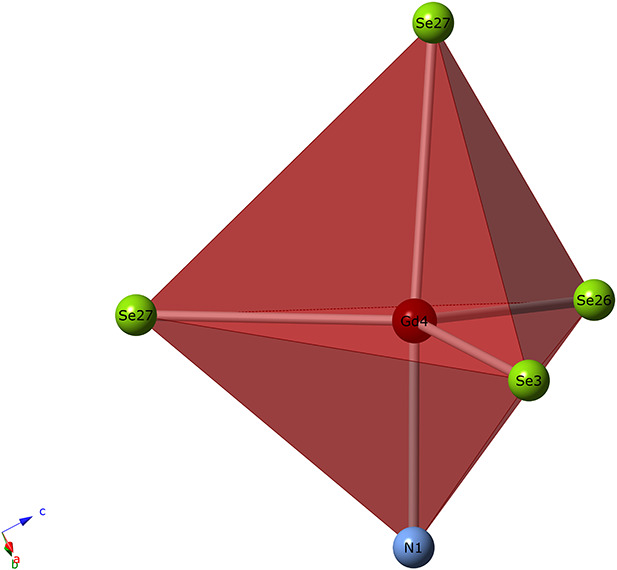
The unusually low 5-fold coordination of Gd(4) in Gd23N5Se27.